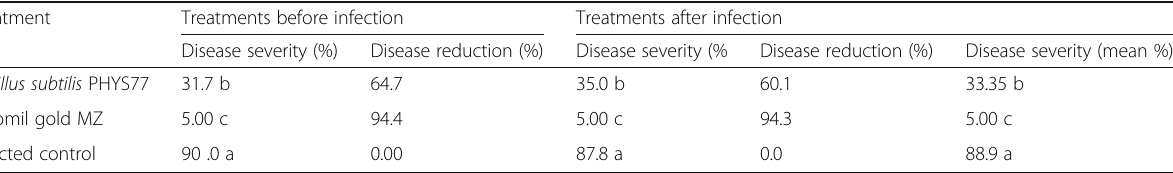
Table 5 Effect of treatment with Bacillus subtilis PHYS77 on disease severity % of BOUB caused by B. allii PHYOA1 under greenhouse